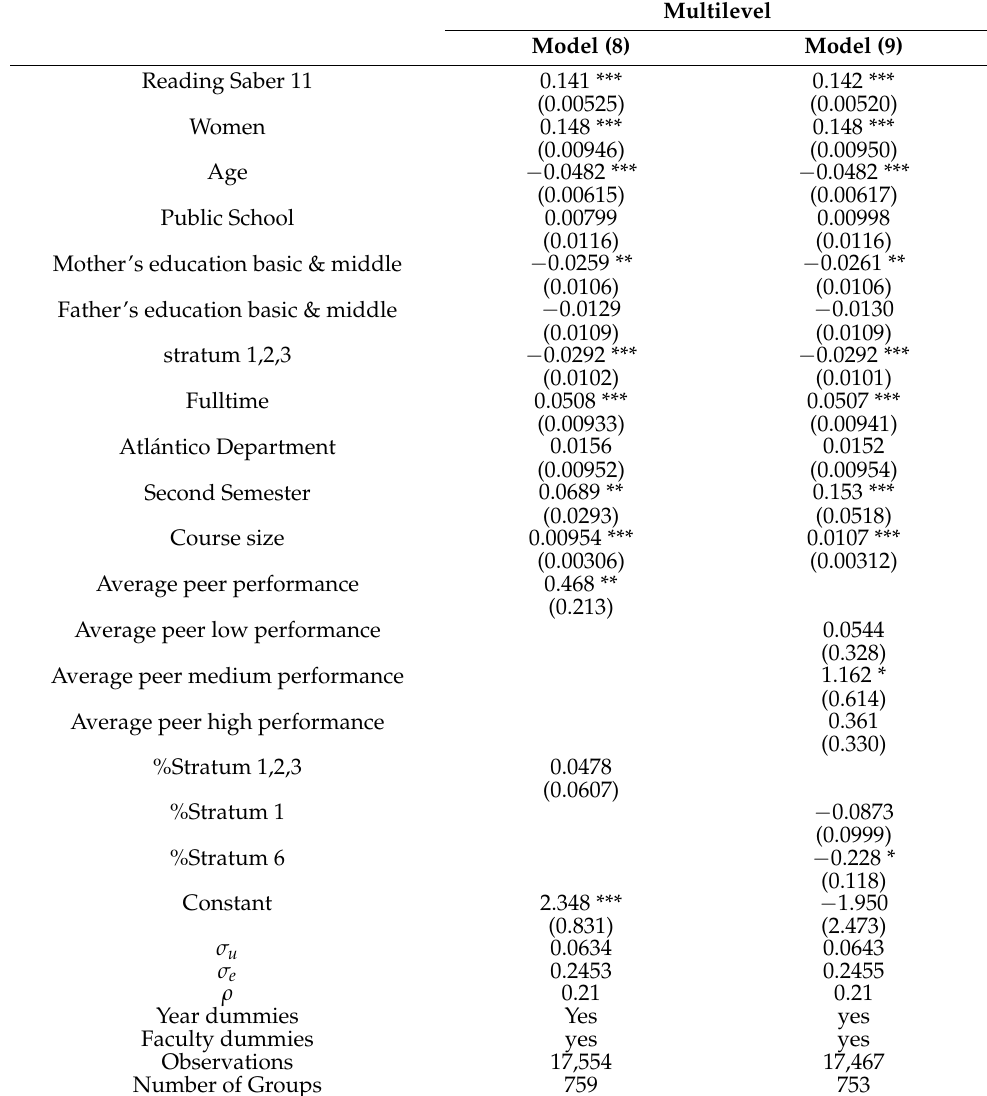
Table 9. Peer effects on academic performance in Communication Skills I—Multilevel.